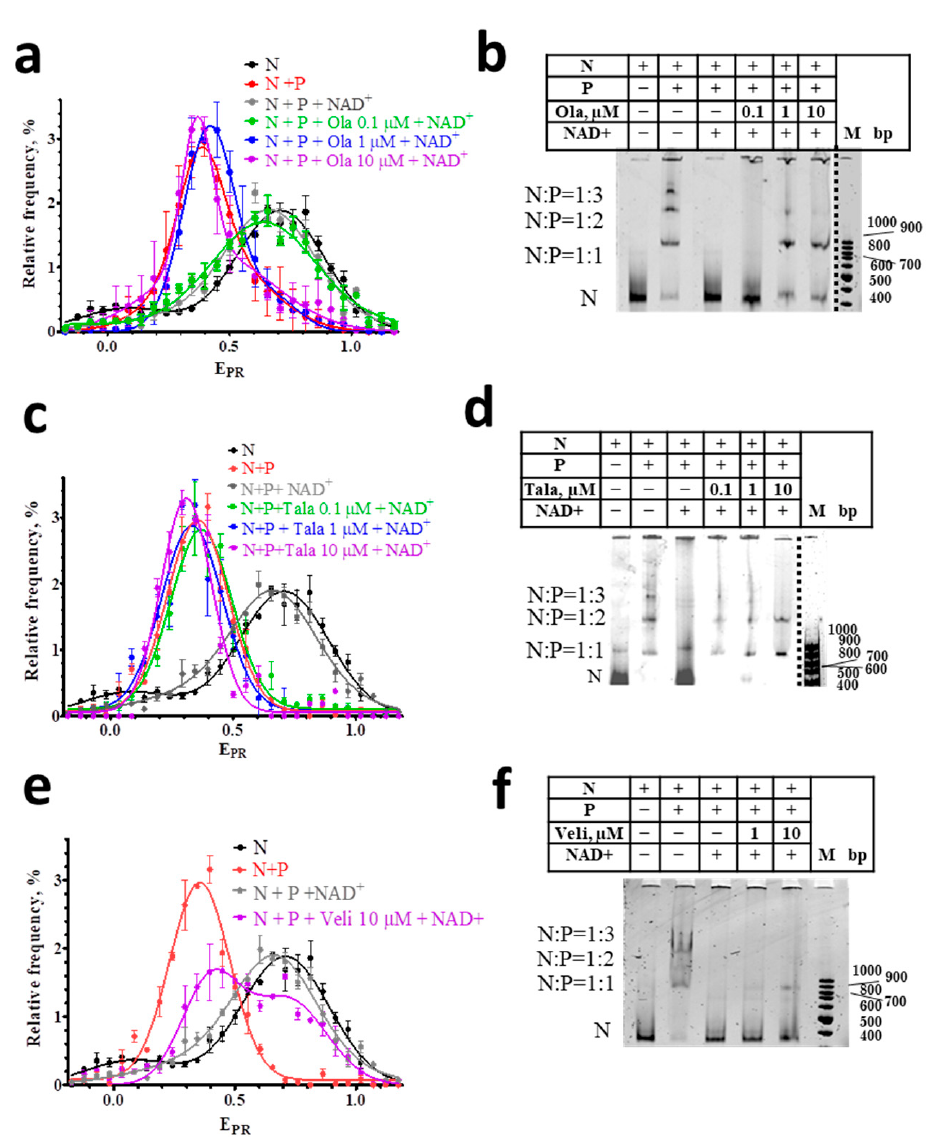
Figure 3. Effect of NAD+ on nucleosome-PARP1-PARPi complexes. ( a , c , e ) E PR profiles of nucleo- somes (N) and nucleosome-PARP1 complexes (N+P) treated with NAD+ (100 µ M) in the presence of different concentrations of Ola ( a ), Tala ( c ), and Veli ( e ). Concentration of PARP1 was 50 nM. E PR profiles are presented as mean ± standard error of the mean ( n = 3). ( b , d , f ) EMSA data for nucleosomes and their complexes with PARP1 (50 nM) treated with NAD+ (100 µ M) and different concentrations of Ola ( b ), Tala ( d ), and Veli ( f